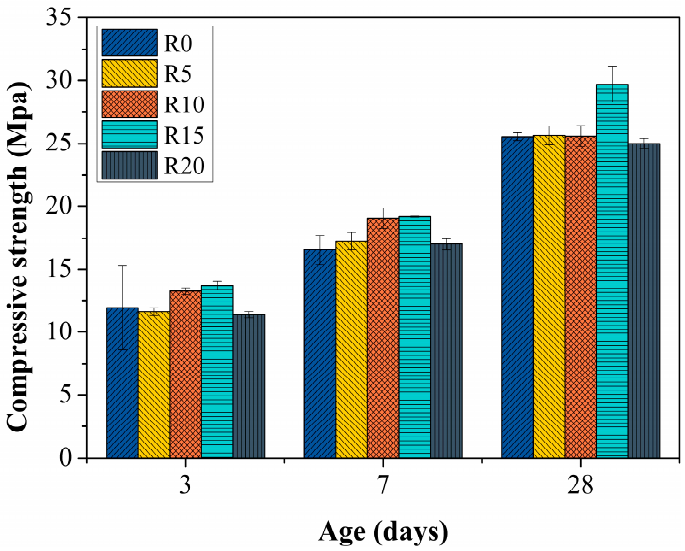
Figure 10. Compressive strength of mortars.